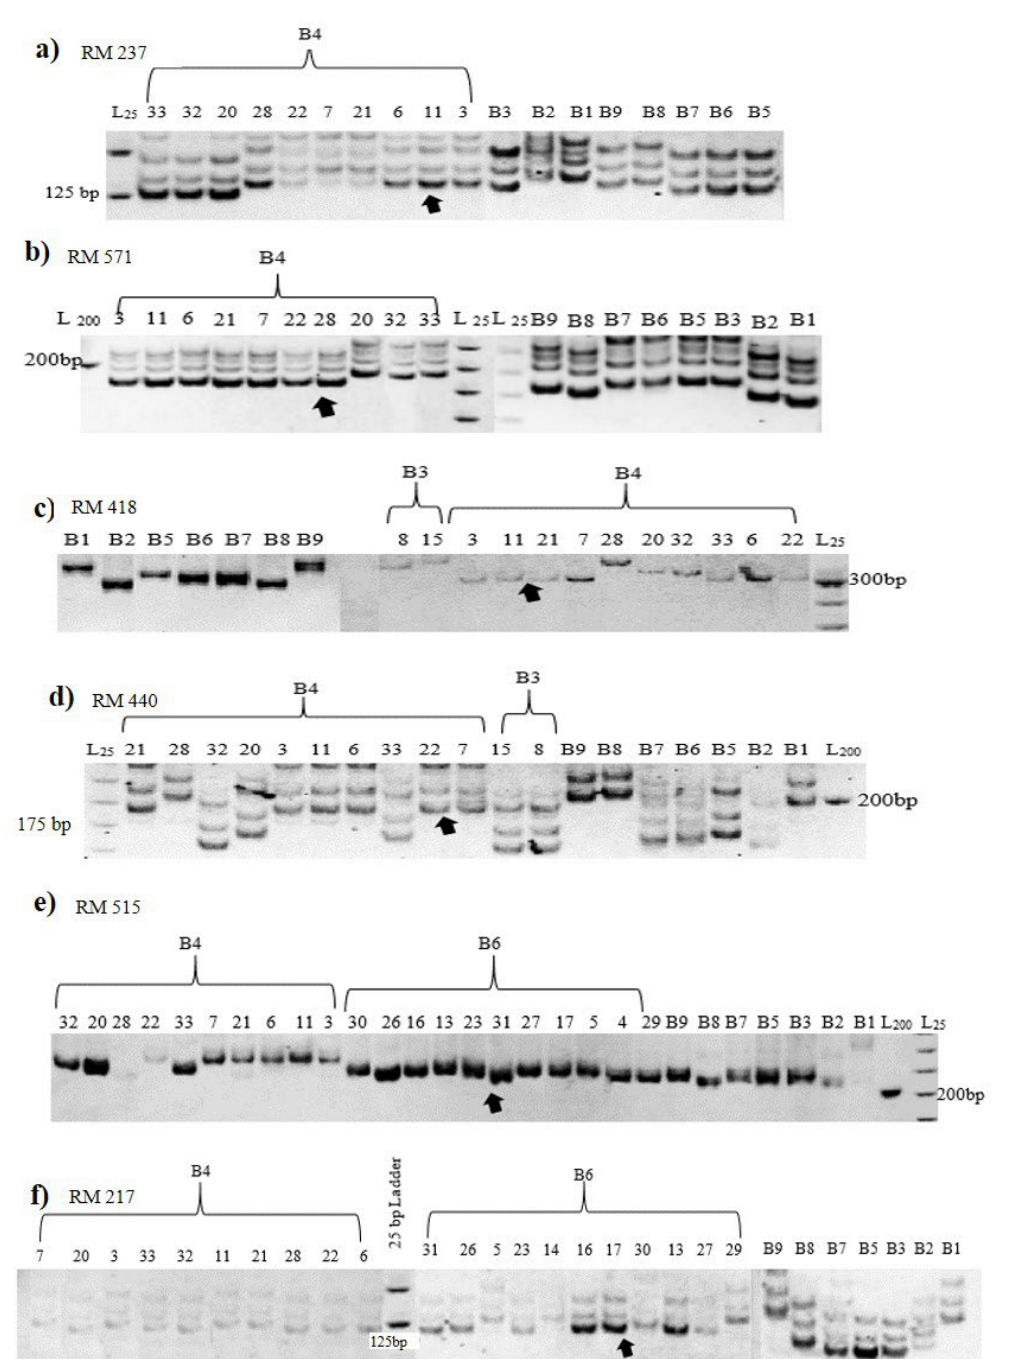
Supplemental Figure 4: PCR profiles of expanded DNA bulks